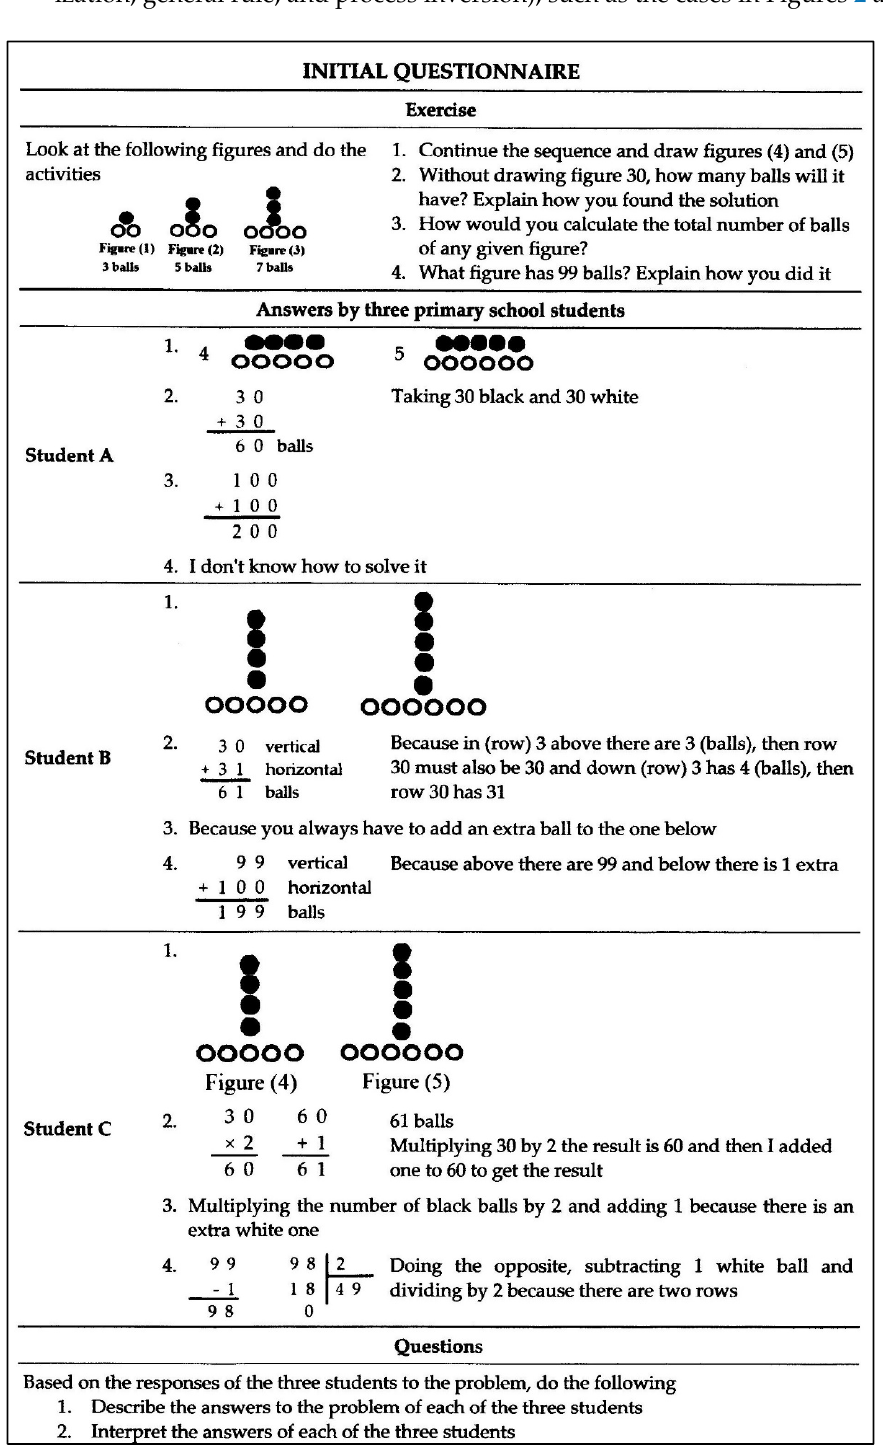
Figure 2. Initial questionnaire. The students’ handwritten answers are transcribed and translated into English for better understanding by the reader.